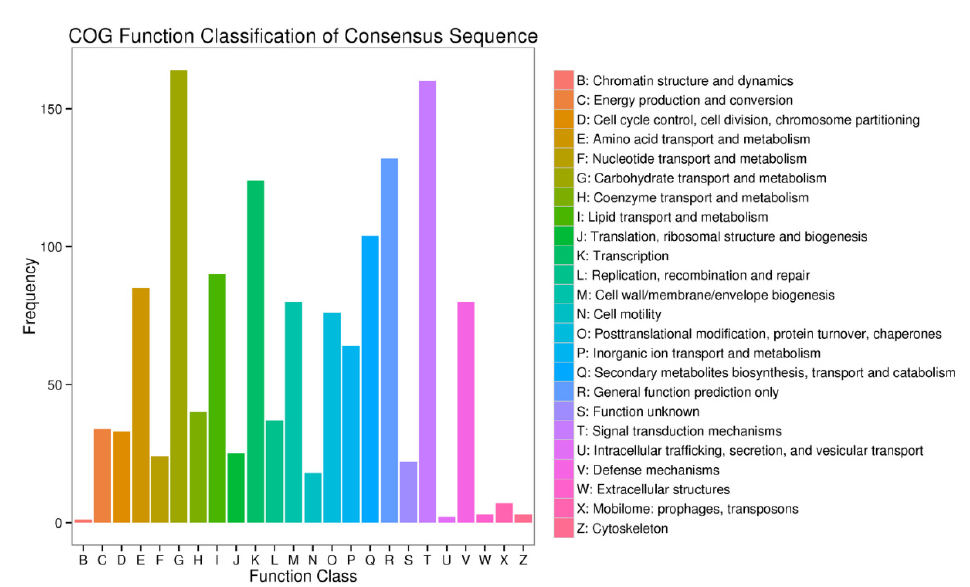
Figure 3. Cluster of Orthologous Groups (COG) functional annotation classification of the differentially expressed genes (DEGs) isolated in S1 vs. S2 from the “Shanxin” poplar xylem.